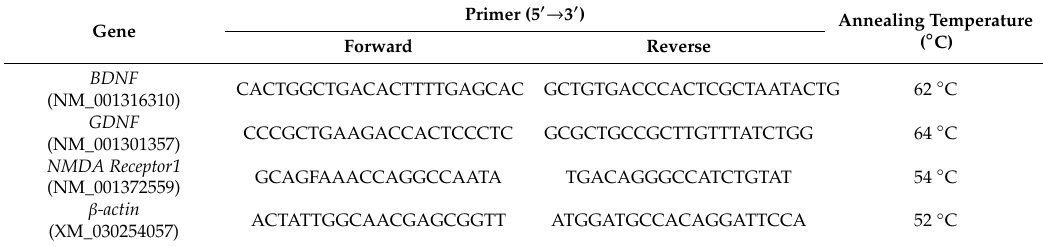
Table 2. Primer sets for real-time